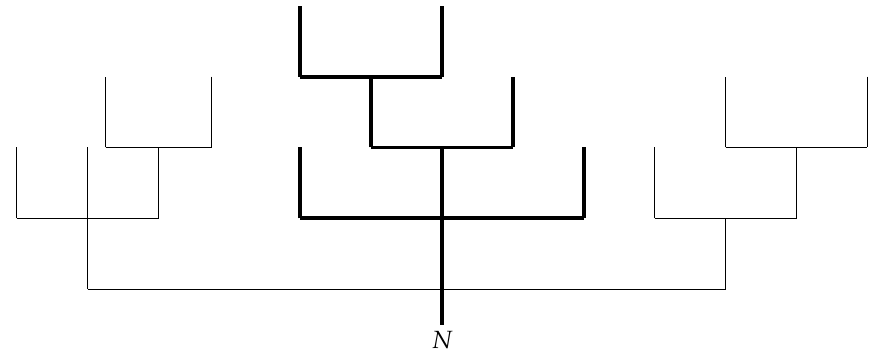
N Fig4. Dendrograms of N. The N ∞ -submoduloid N 2 of N is shown by thick lines. Figure 4. Dendrograms of N. The N ∞ -submoduloid N 2 of N is shown by thick